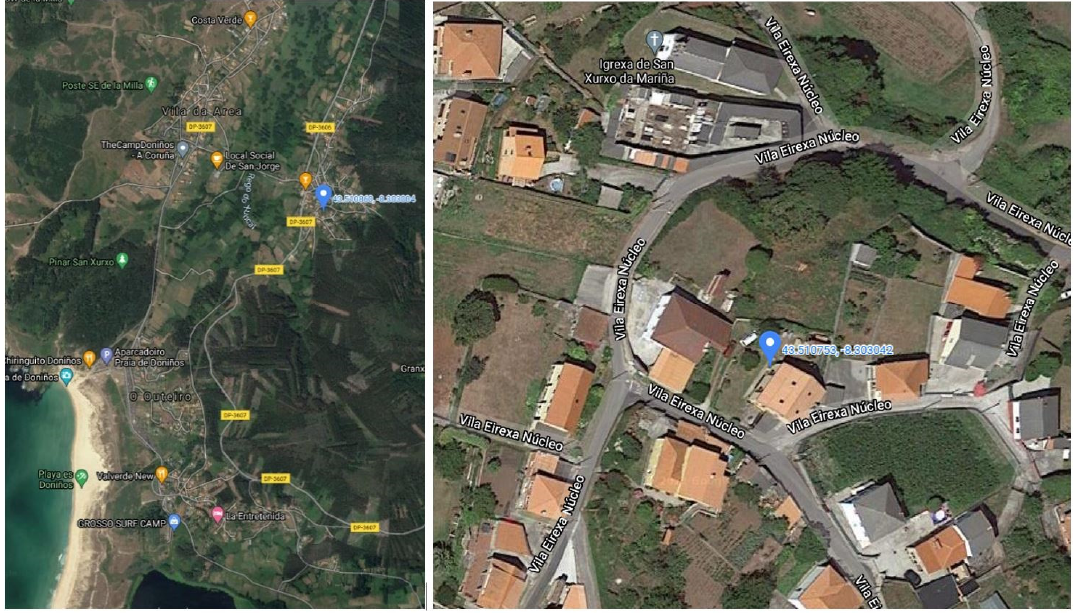
Figure 1. Location of the building. Source: Google Maps.